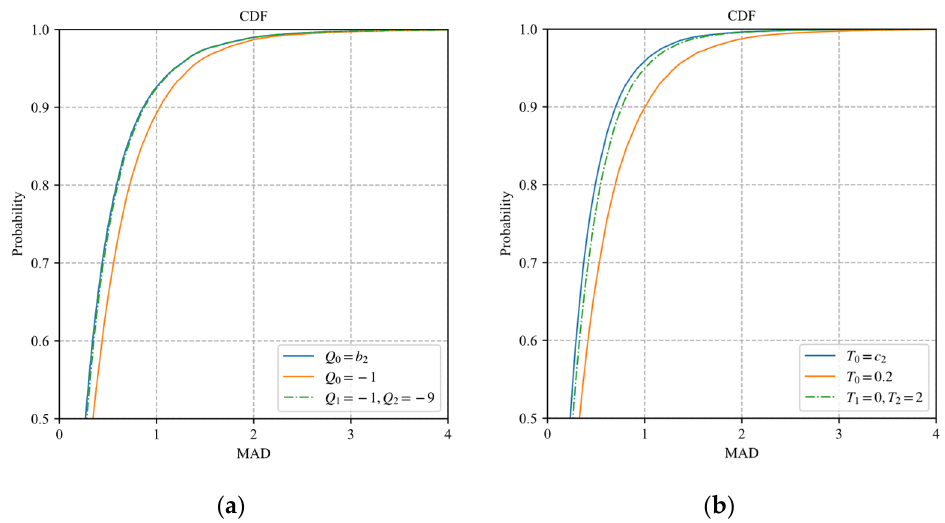
Figure 10. The CDF curves of MAD of the prediction distortion vectors predicted by models (34)–(37): ( a ) models (34)–(35); ( b ) models (36)–(37).